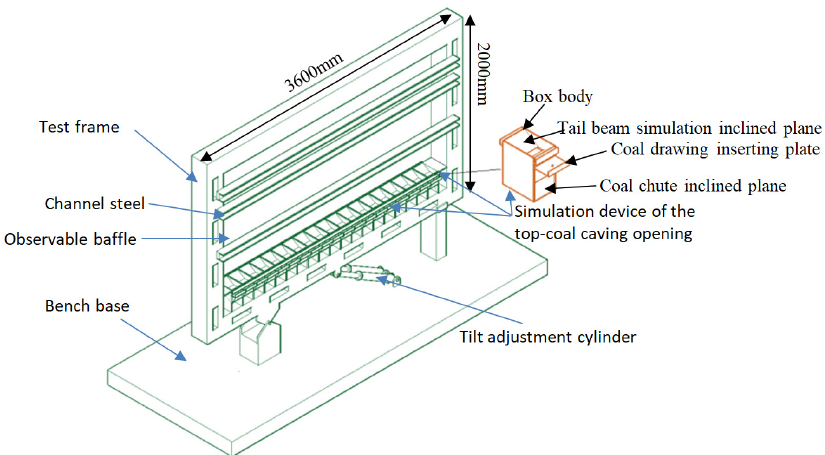
Figure 9. Three dimensional diagram of coal caving test platform.